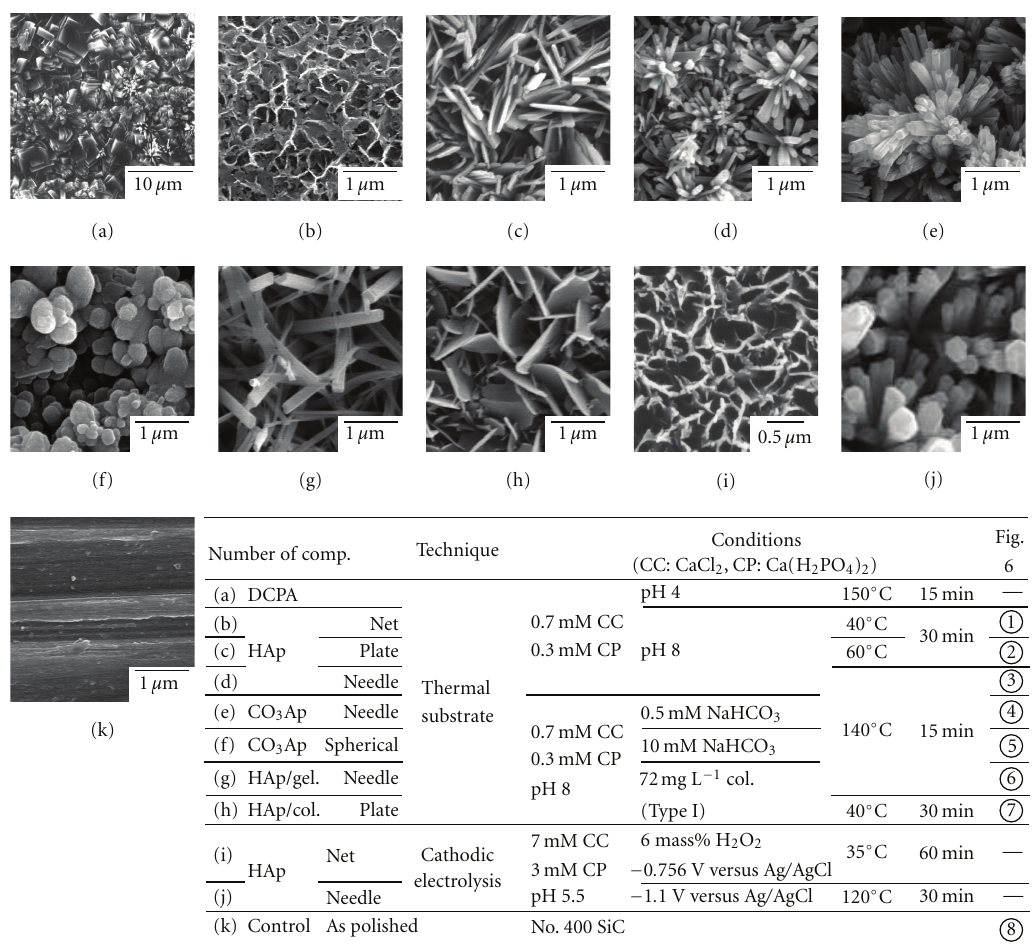
Figure 4: SEM photographs of the surface of the samples treated by various